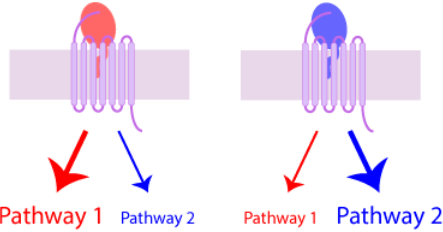
Figure 6. Schematic representation of biased agonism. The red chemokine ( left ) selectively activates pathway 1, whereas the blue chemokine ( right ) selectively activates pathway 2.